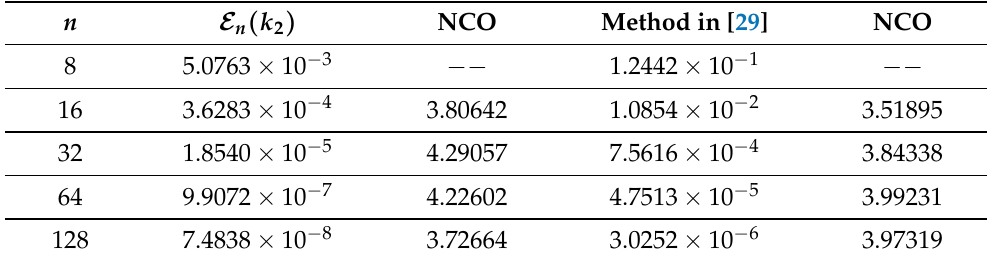
Table 5. Estimated errors for function k 2 , and NCOs with different values of n .